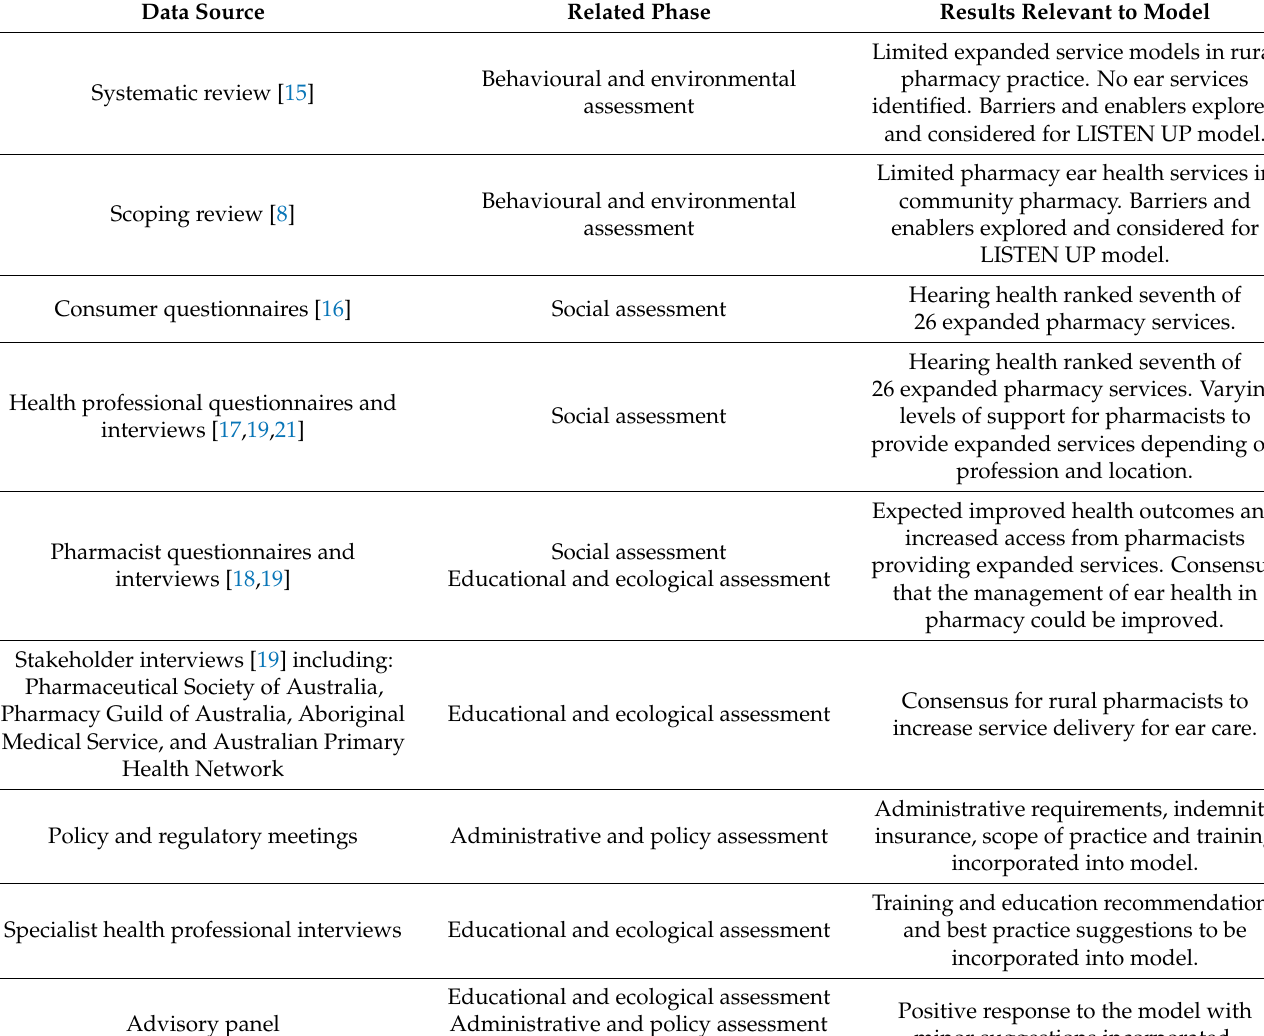
Table 2. PRECEDE Results with linkage to data